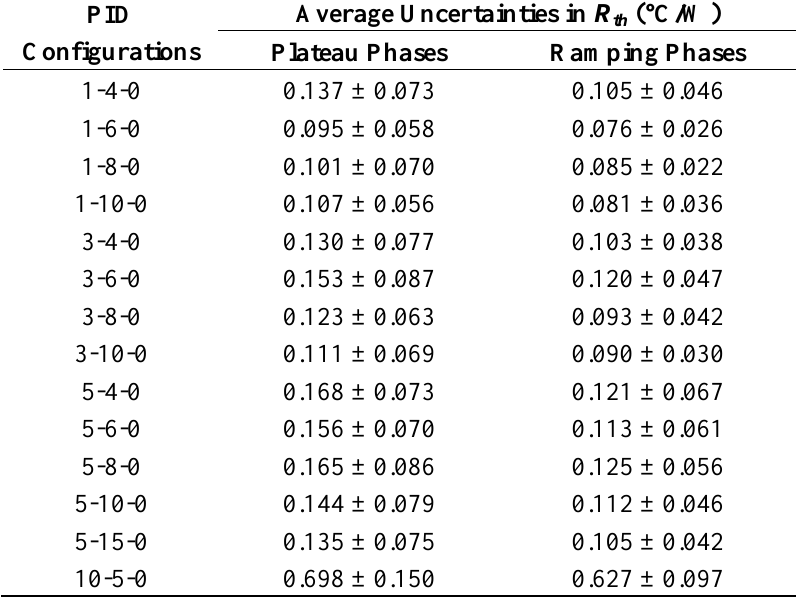
Table 1. The PID parameters shown in this table were selected after demarcating a specific regime. Hereby, it was possible to sharpen the PID parameters to be used. The first column gives a representation of the used PID configurations. The numbers illustrate respectively the proportional, integral, and derivative factors. The second and third column act as the calculated average uncertainty in R for plateau phases and ramping phases for the entire th temperature